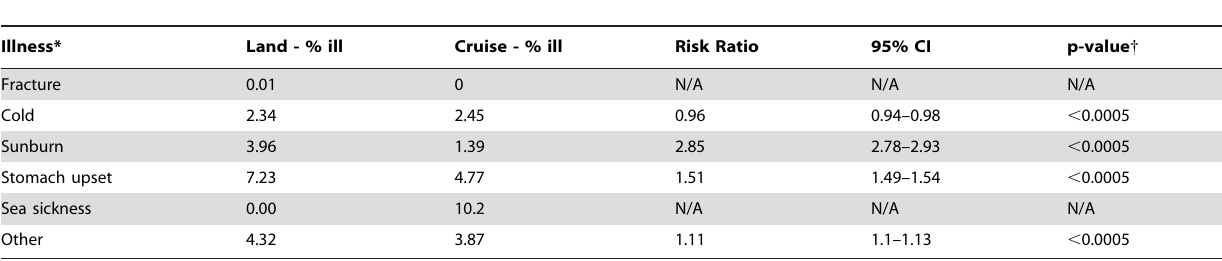
Table 2. Disease frequency in travellers on land- and cruise-based